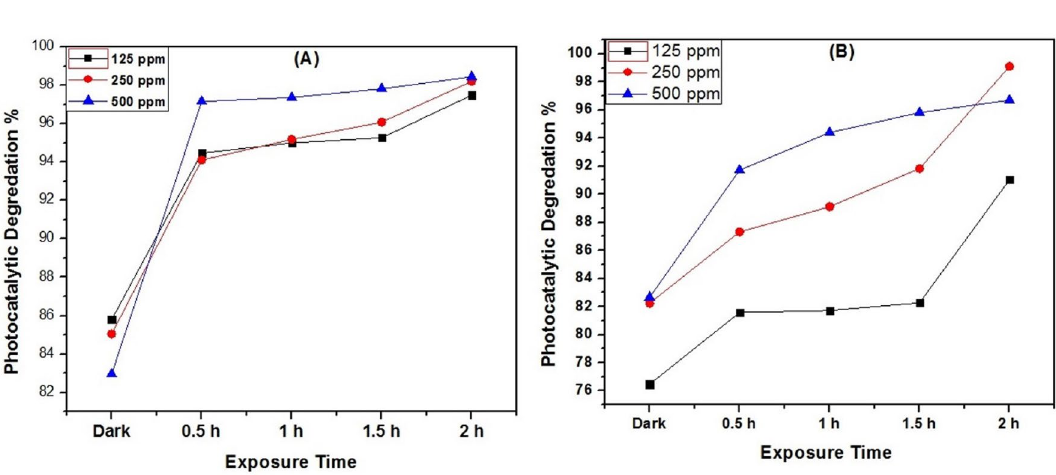
Figure 7. Photocatalytic degradation efficiency of crude oil, using different prepared samples ( A MT18 and B